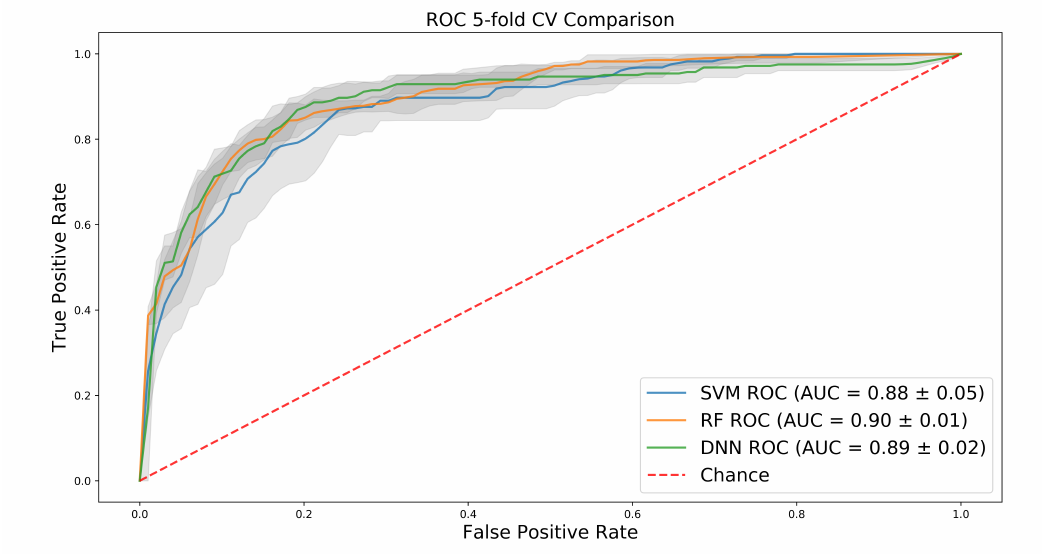
Figure 3. Mean ROC (Receiver operating characteristic) curves over 5-fold cross-validation for support vector machines (SVM), random forest (RF), and deep neural networks (DNN) with 1 standard deviation shown in grey. Table 1. Classification report containing precision, recall and F1 score for DNN and baselines on test data. 0–3 correspond to the four classes “non-responsive”, “antagonist”, “agonist”, and ”mixed-response”. Avg = weighted average for each metric according to number of samples for each class. MCC = Matthew’s correlation coefficient.